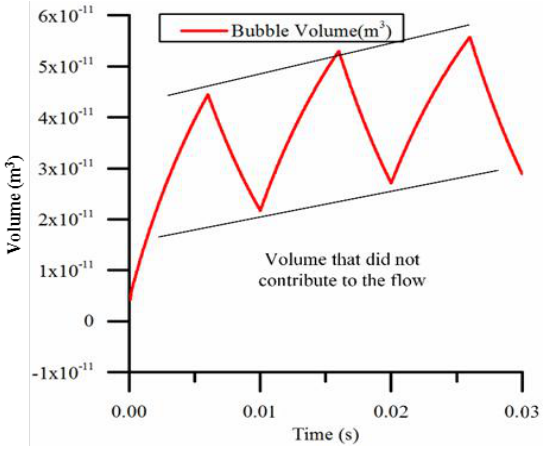
Figure 11. The bubble volume calculated by the model when the duty cycle is 60% and the heating frequency is 100 Hz. frequency is 100 Hz.